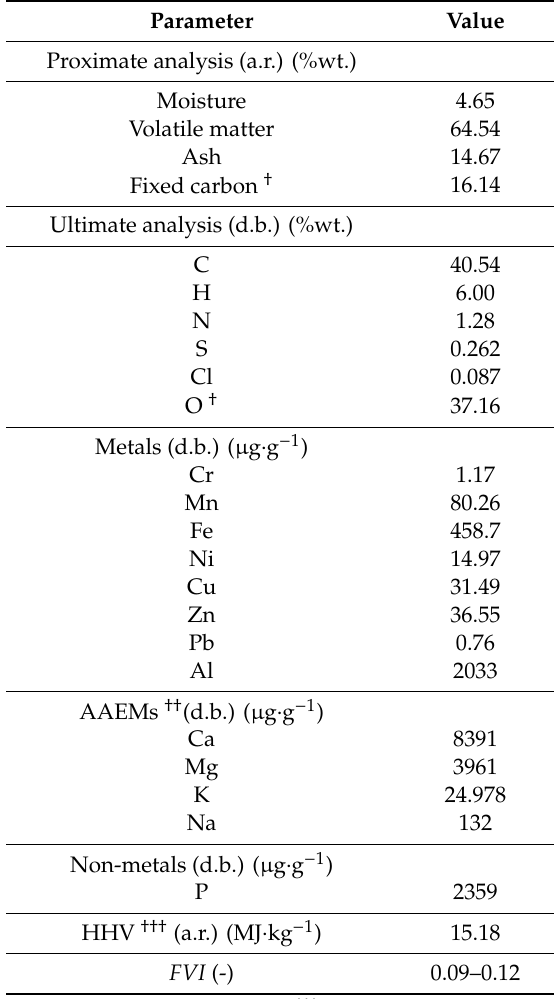
Table 1. Physicochemical properties of tobacco waste